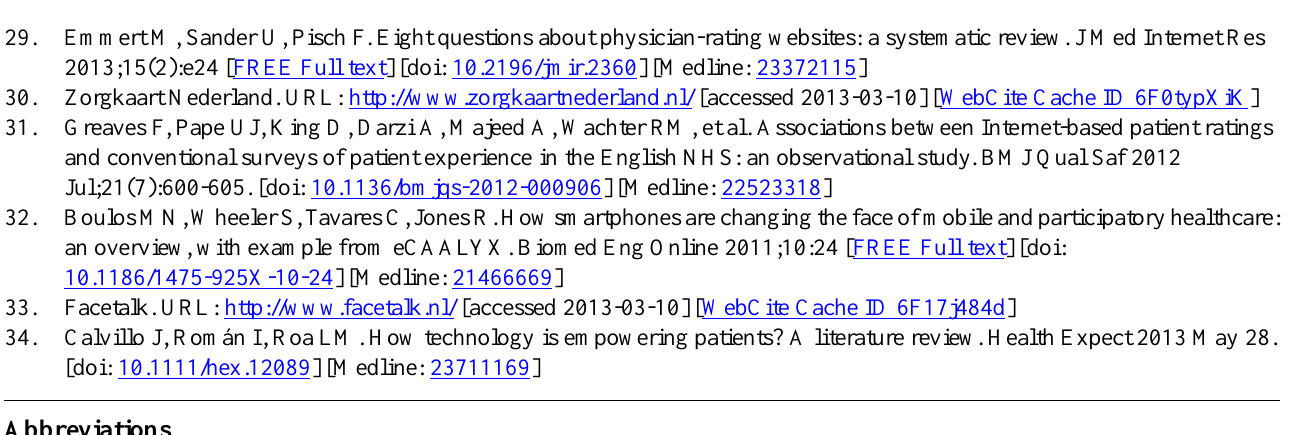
CBS: Centraal Bureau voor de Statistiek (Statistics